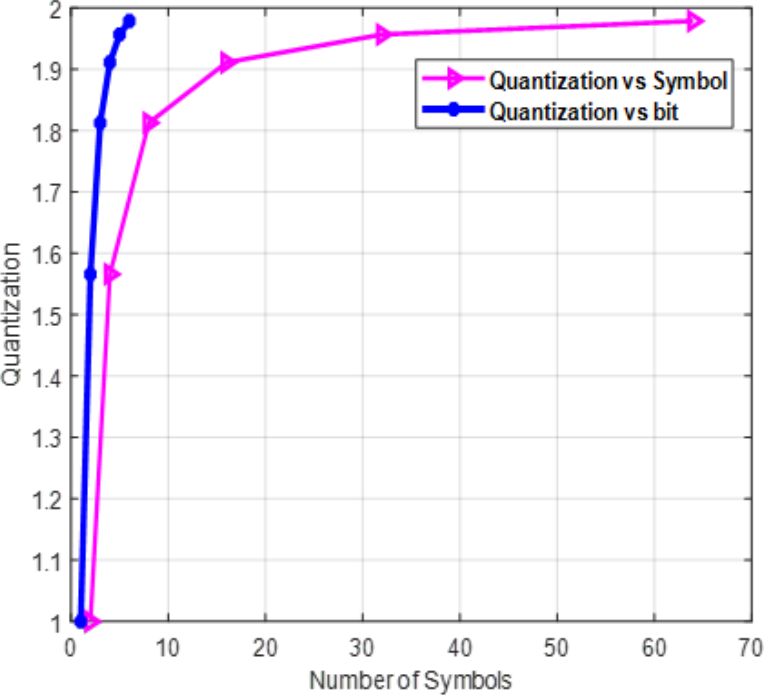
Figure 3. Quantization versus number of symbols with BPSK